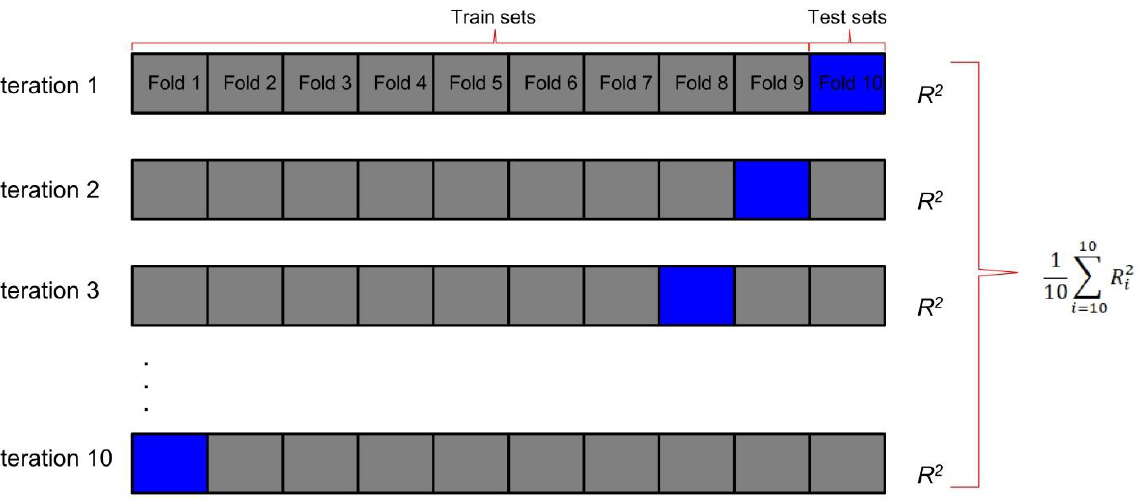
Figure 4. K-Fold Cross-Validation.